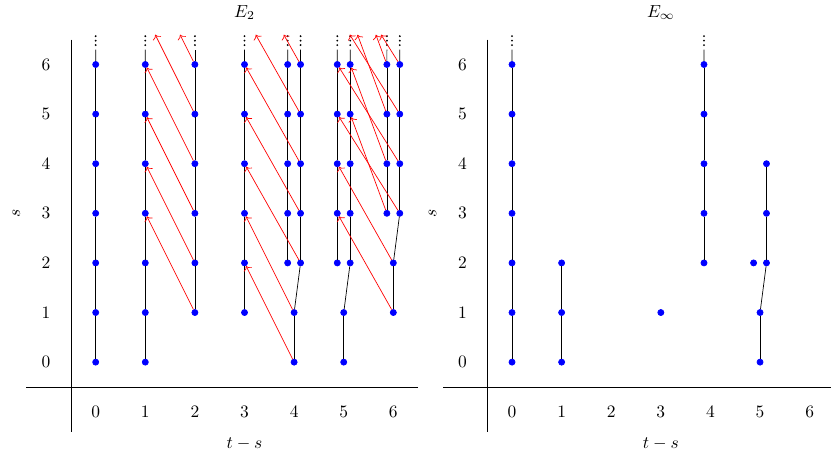
Figure 10: The E and E ∞ pages of the Adams chart for H • ( B ( (cid:90) / 2 2 )) 2 ξ ) . 2 Table 2: The bordism groups with Spin- (cid:90) / 2 m + 1 structure in degrees d ≤ 6 for m > 1. d 0 1 2 3 4 5 6 + Ω Spin- (cid:90) / 2 m